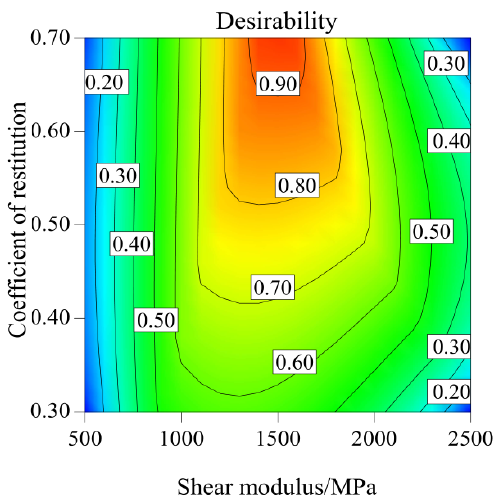
Figure 6. Desirability contour map dominant frequency and velocity as indicators.